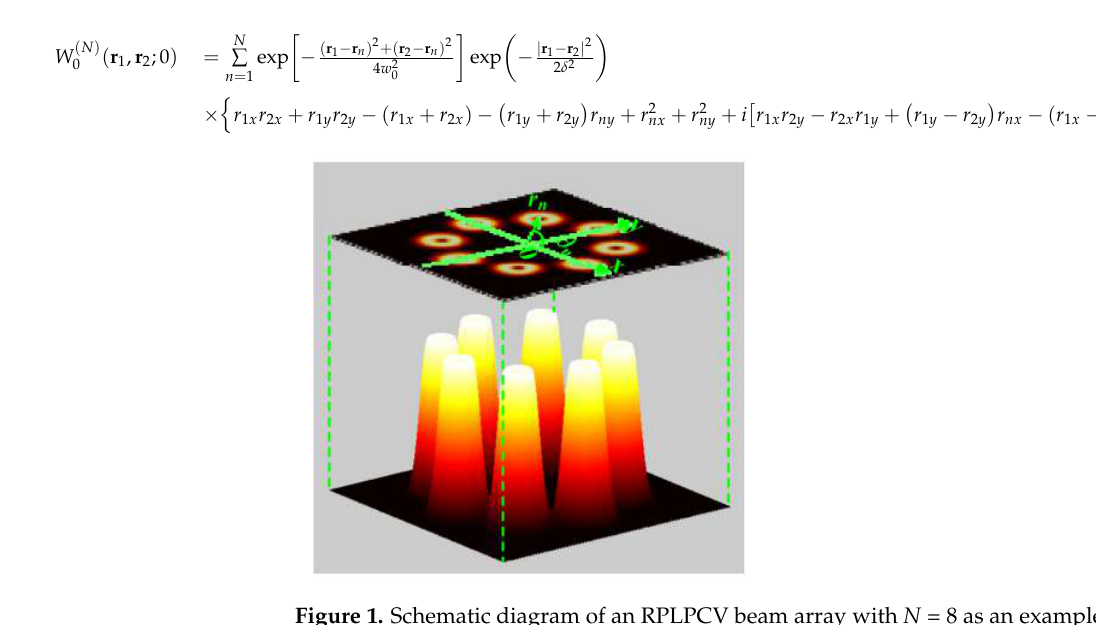
Figure 1. Schematic diagram of an RPLPCV beam array with N = 8 as an example. According to the extended Huygens–Fresnel principle [32], the CSDF of the RPLPCV beam array propagated close to the positive z -axis into the half-space z > 0 is given by: (cid:20) (cid:16) (cid:17) 2 (cid:82) (cid:82) N k ∑ − ( r 1 − r n ) 2 +( r 2 − r n ) 2 W ( N ) ( ρ 1 , ρ 2 ; z ) = exp 2 π z 4 w 2 n = 1